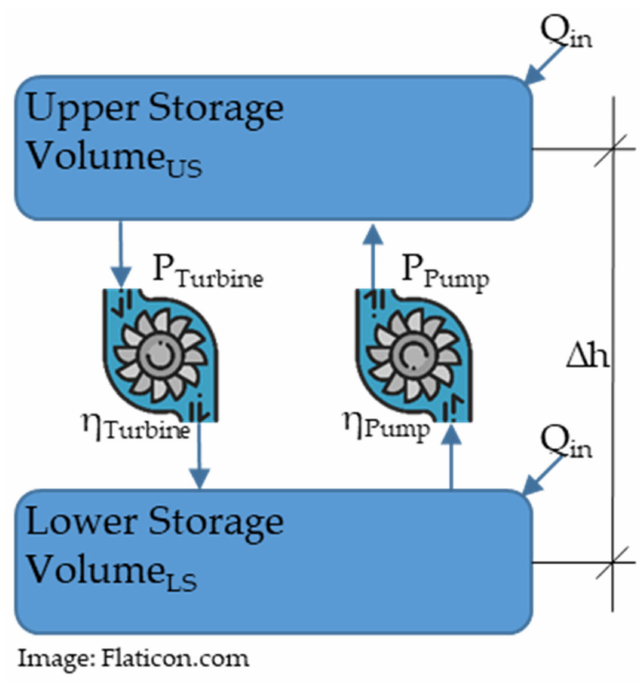
Figure 11. (Pumped)-storage hydropower plant